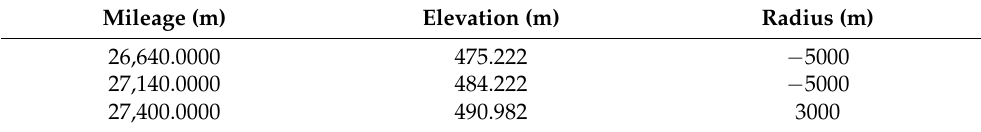
Table 2. Example of vertical curve design.